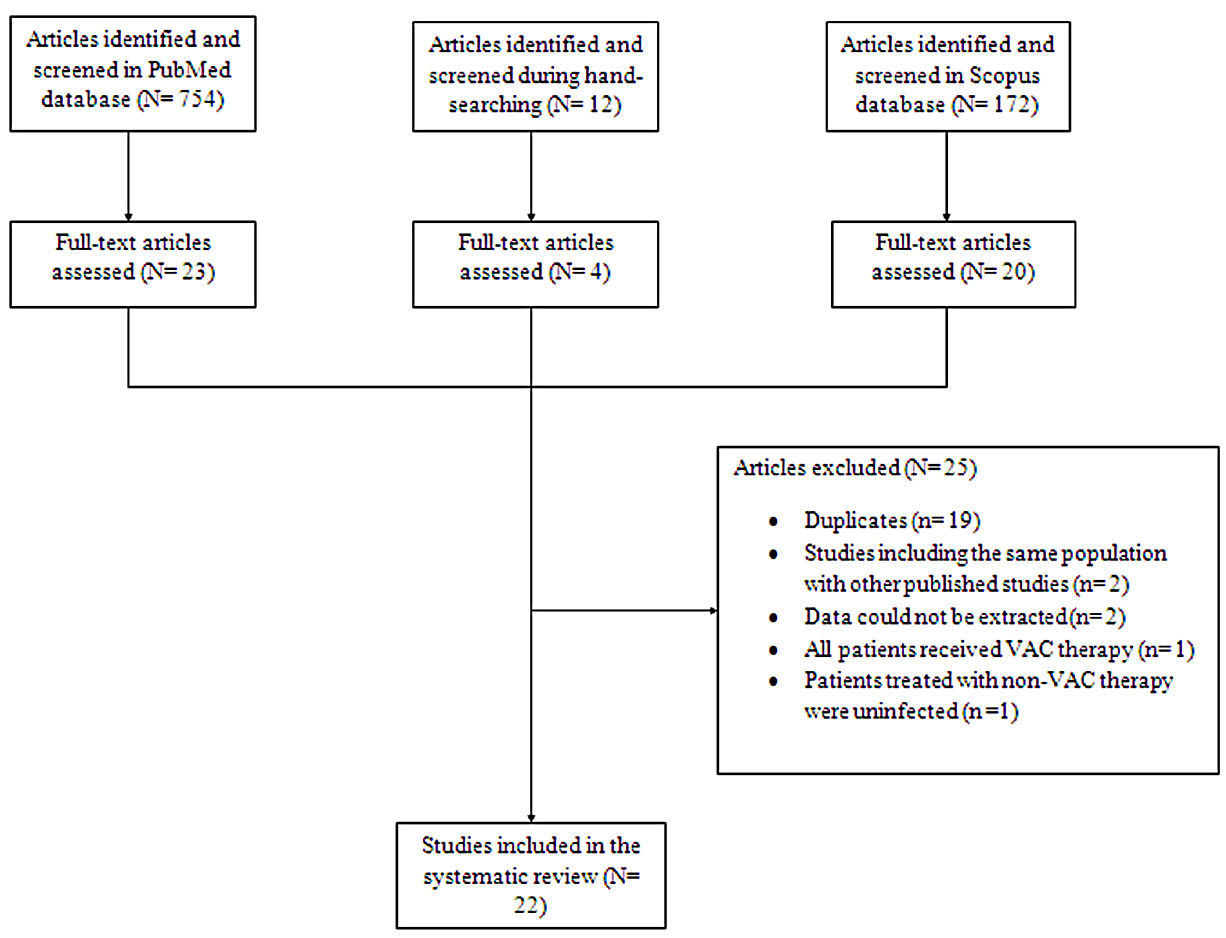
Figure 1. Flow diagram of the systematic search and study selection process.